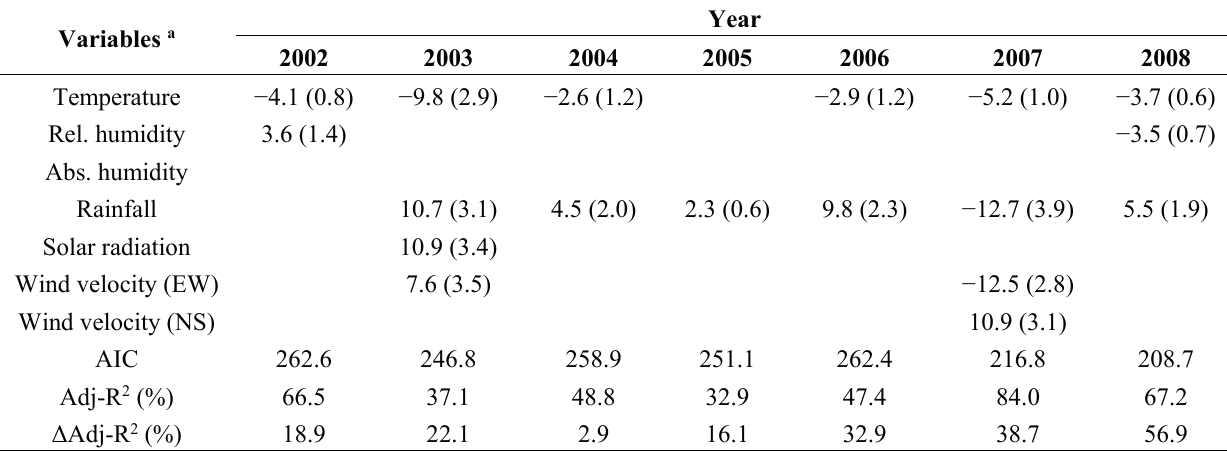
Table 1. Estimates (standard error) of significant meteorological determinants on changes of influenza transmission rate.